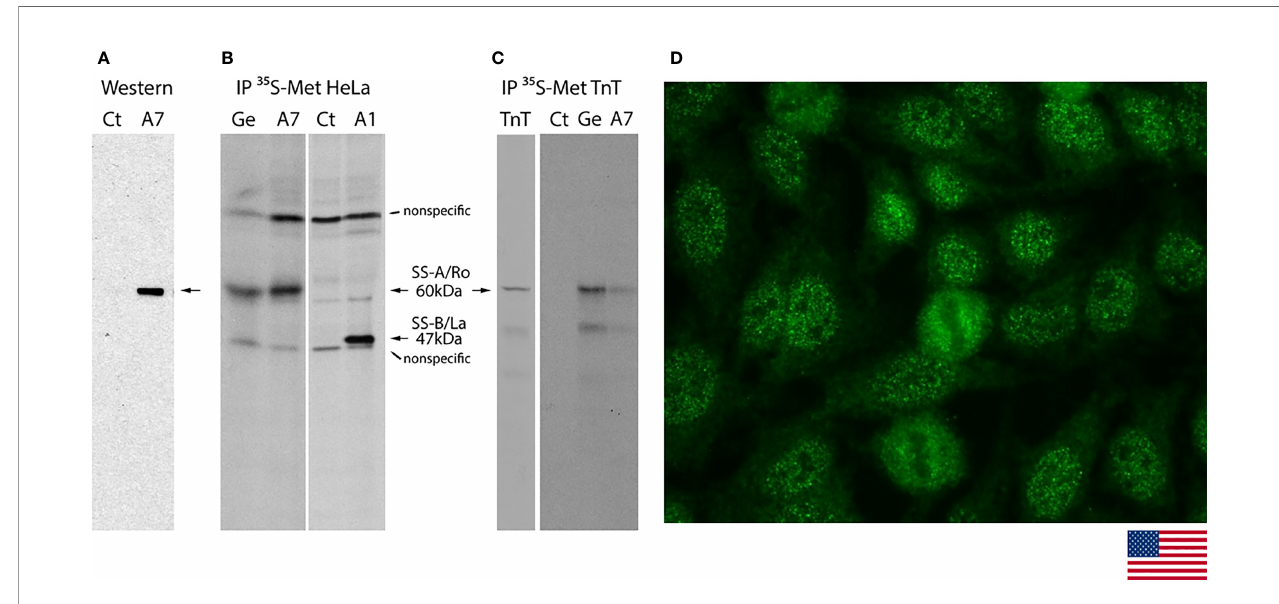
FIGURE 4 | Characterization of SS-A/Ro60 monoclonal antibody A7 in Western blotting, immunoprecipitation, and indirect immuno fl uorescence on HEp-2 cells. (A) Western blot analysis of A7 showed reactivity to the 60 kDa protein (arrow) in the MOLT-4 cell lysate. Control (Ct) culture supernatant showed no reactivity. (B) Immunoprecipitation (IP) with lysate from HeLa cells metabolically labeled with [ 35 S]-methionine. Ge and A1 are human prototype serum for anti-SS-A/Ro and mouse monoclonal antibody to SS-B/La, respectively. The non-speci fi c bands showing in all lanes were seen when secondary bridging antibody was used. (C) IP with in vitro